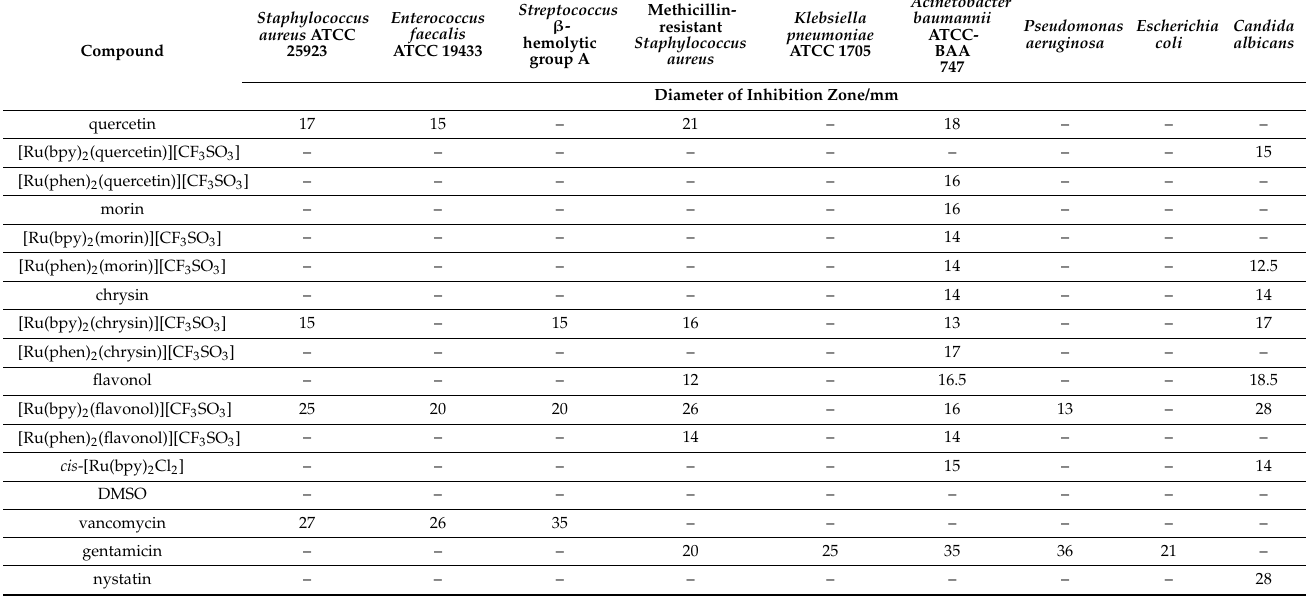
Table 4. Antimicrobial activity, measured by the diameter of the inhibition zone using the disc diffusion method, of ruthenium flavonoid complexes with 2,2 (cid:48) -bipyridine and phenanthroline ligands, compared to the activities of the ruthenium precursor, cis -[Ru(bpy) 2 Cl 2 ]. DMSO was used as a negative control and drugs vancomycin, gentamicin and nystatin were used as positive